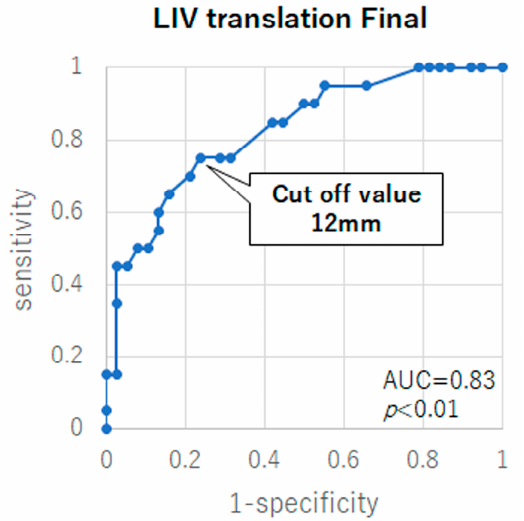
Figure 2. Receiver-operating characteristic (ROC) curve of the lowest instrumented vertebra (LIV) translation at the final follow-up for good outcomes (L4 tilt < 8° and C7 translation from the center sacral vertical line < 15 mm) at the final follow-up. AUC indicates area under the ROC curve.